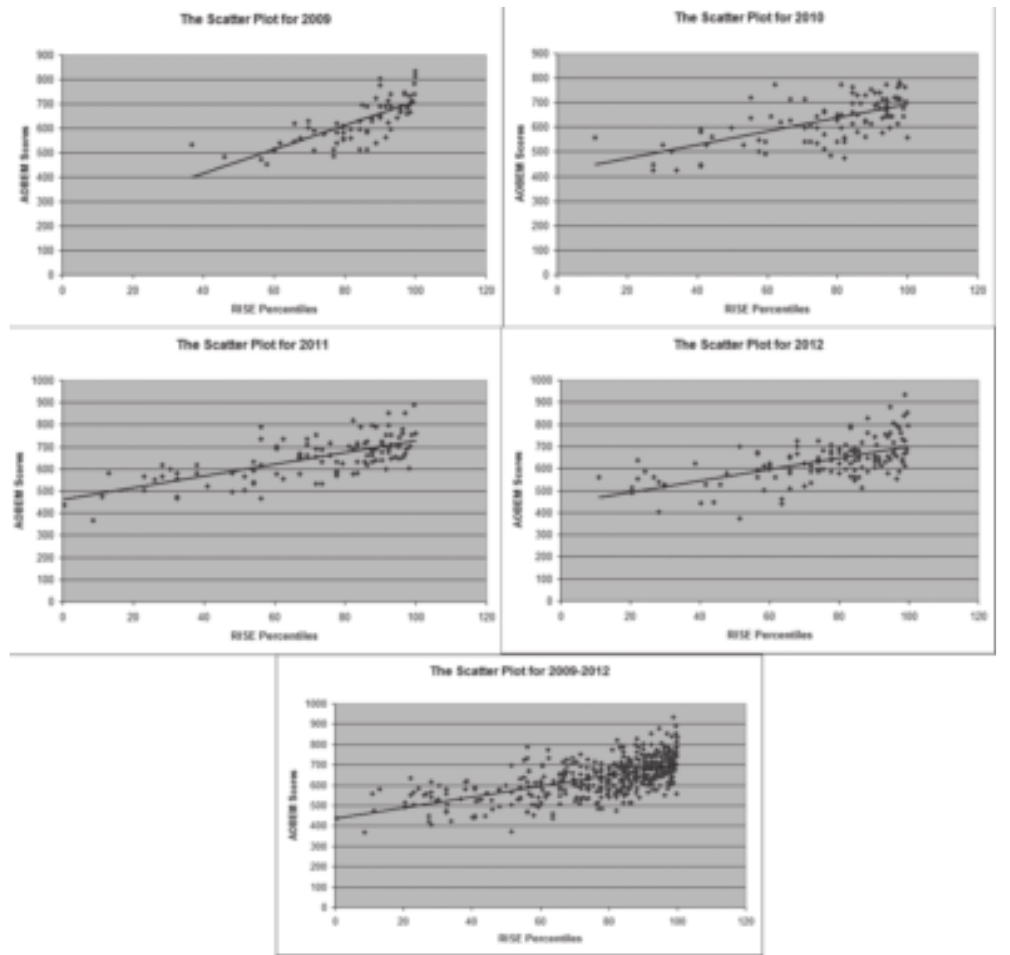
Figure 1 . Scatter plots for the Resident In-Service Examination (RISE) Percentiles vs. the American Osteopathic Board of Emergency Medicine (AOBEM) Part 1 score for each of four years and all four years combined. Correlation coefficients and 95% confidence intervals are in Table